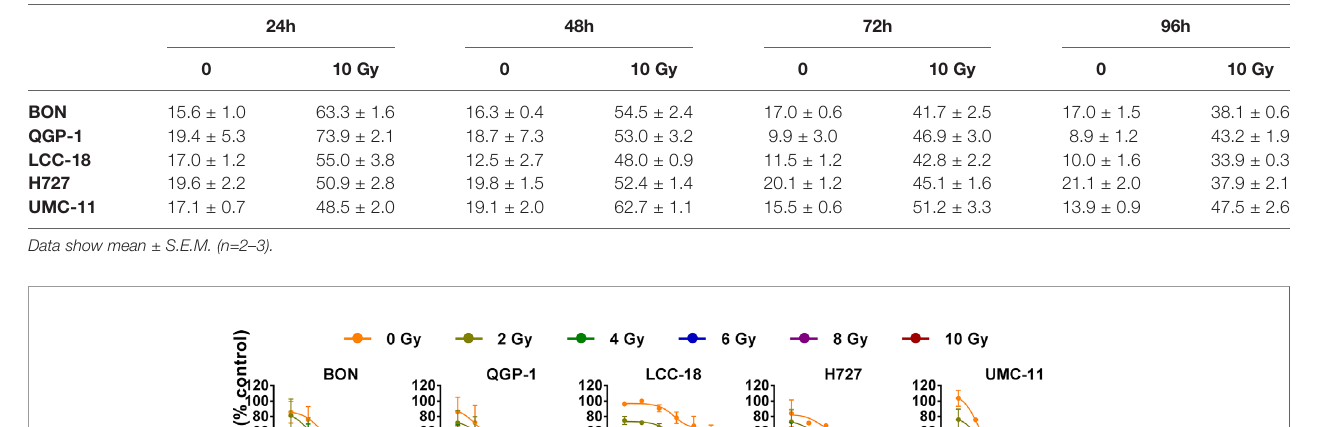
TABLE 3 | Percentages of cells in G2/M cell cycle after irradiation.